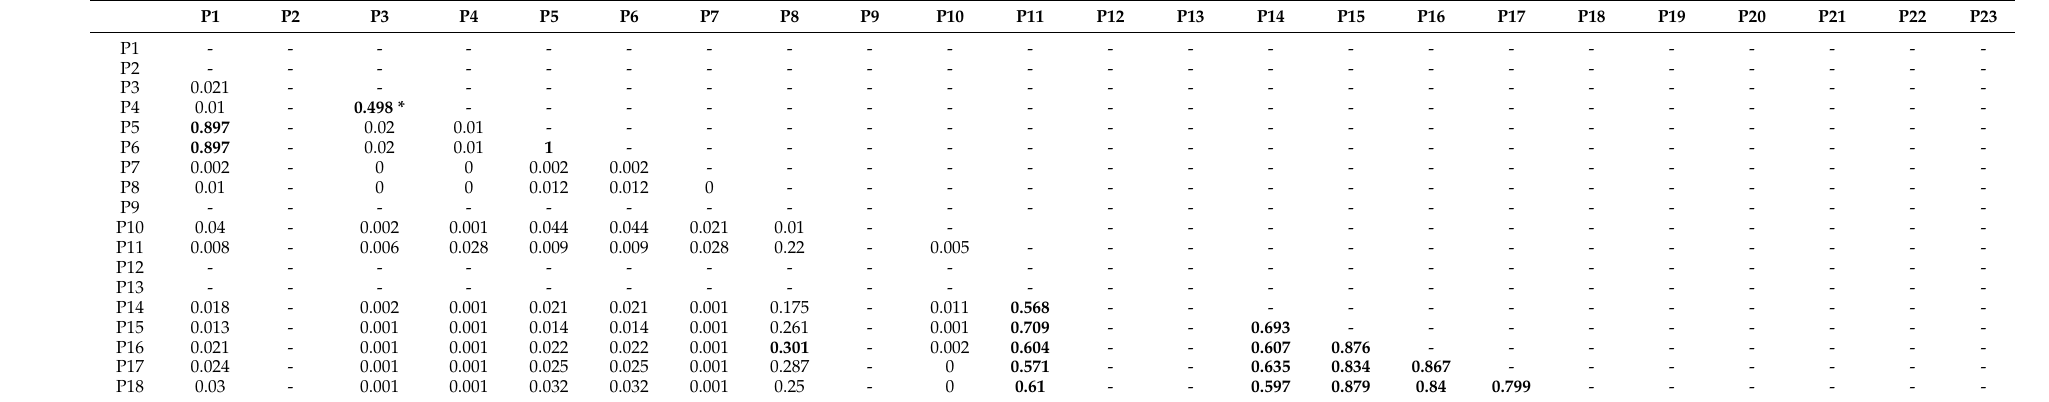
Table 4. Linkage disequilibrium (LD) scores among 23 polymorphisms of the bovine IFITM3 gene in Holstein